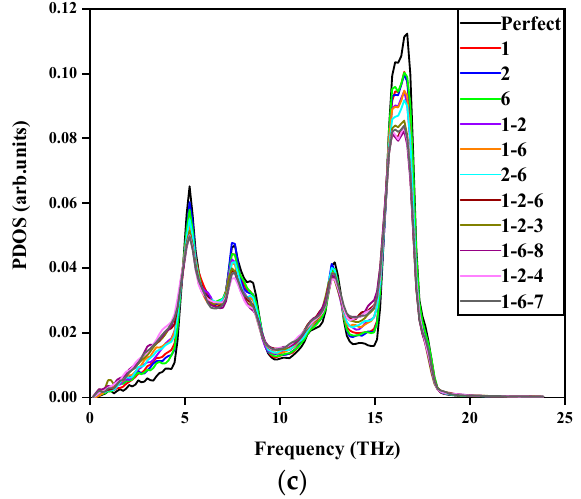
Figure 5. PDOS: ( a ) concave; ( b ) perforation; ( c ) amorphous. The numbers represent small block labels.